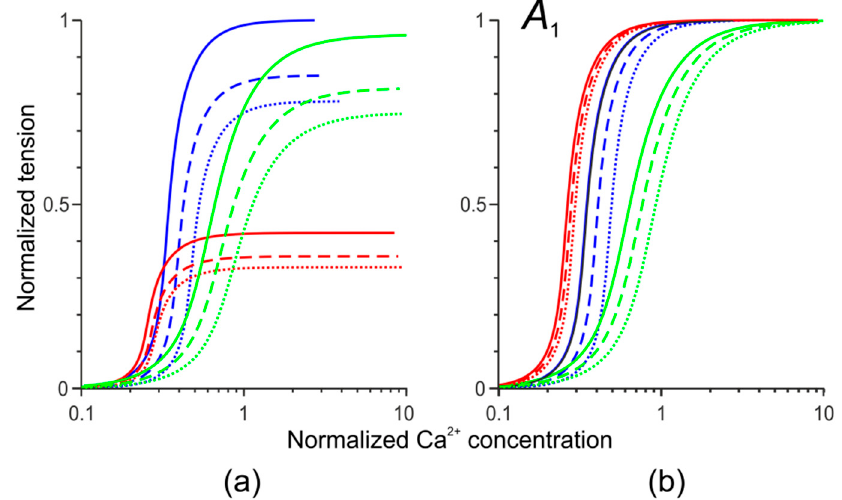
Figure 1. The dependence of the normalized isometric tension ( a ) and thin filament activation A 1 ( b ) on the dimensionless concentration of Ca 2+ ions for the simulation of normal cardiac muscle (blue) and of those with the Ile284Val (red) and Asp230Asn (green) tropomyosin (Tpm) mutations. Continuous, dashed, and dotted lines correspond to sarcomere lengths of 2.2 μ m, 2.0 μ m, and 1.8 μ m, respectively.